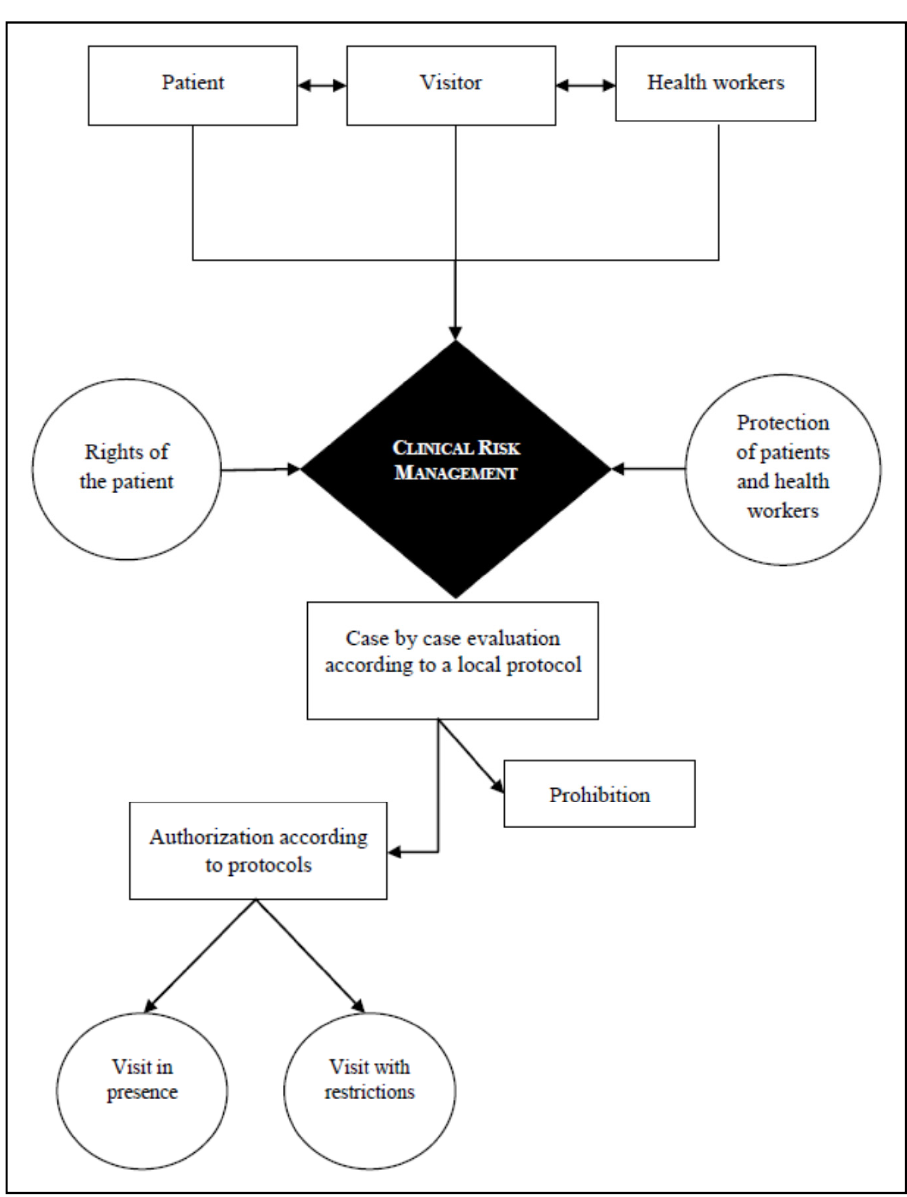
Figure 1. Steps for prevention and intervention in managing visitation in nursing homes.